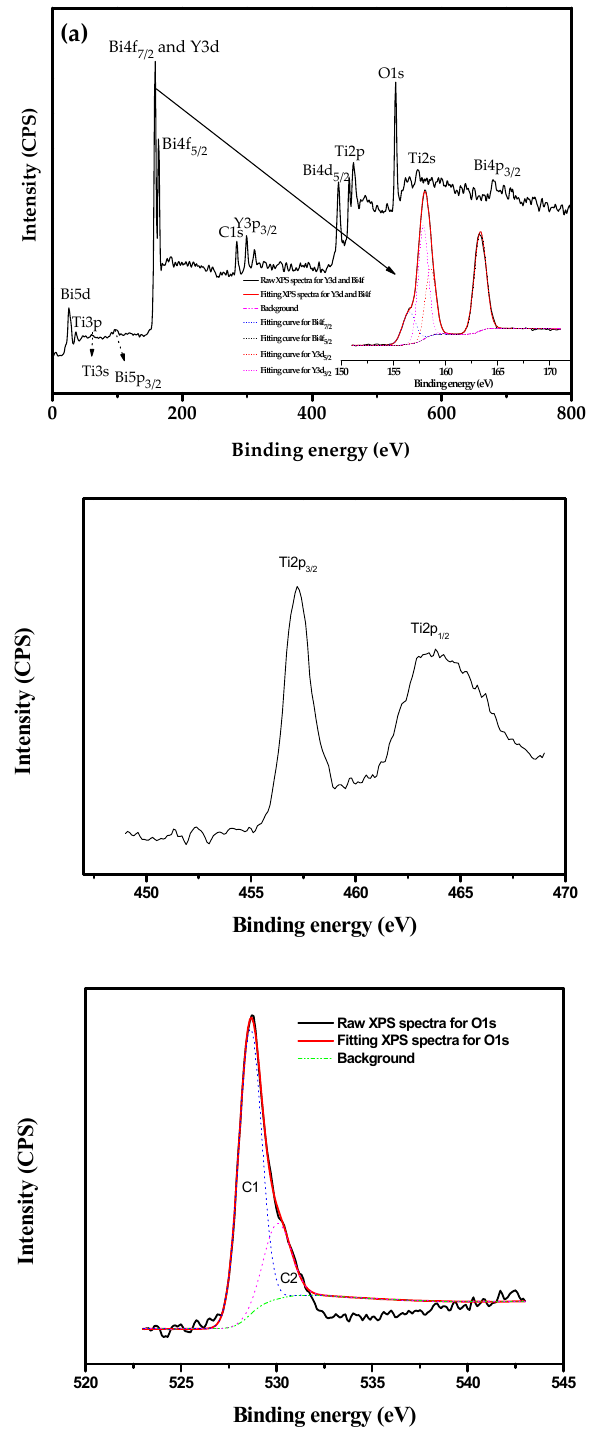
Figure 7. ( a ) Full XPS regions for BiYTi 2 O 7 (Inset is the enlarged range of the Bi4f and Y3d peak); XPS spectra of: ( b ) Ti2p; and ( c ) O1s of BiYTi 2 O 7